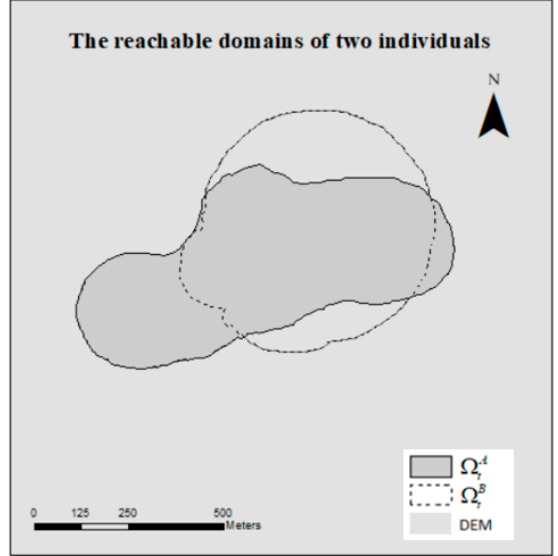
ISPRS Int. J. Geo-Inf. 2019 , 8 , x FOR PEER REVIEW Figure 8. The reachable domains of two individuals at time t . Figure 8. The reachable domains of two individuals at time t.